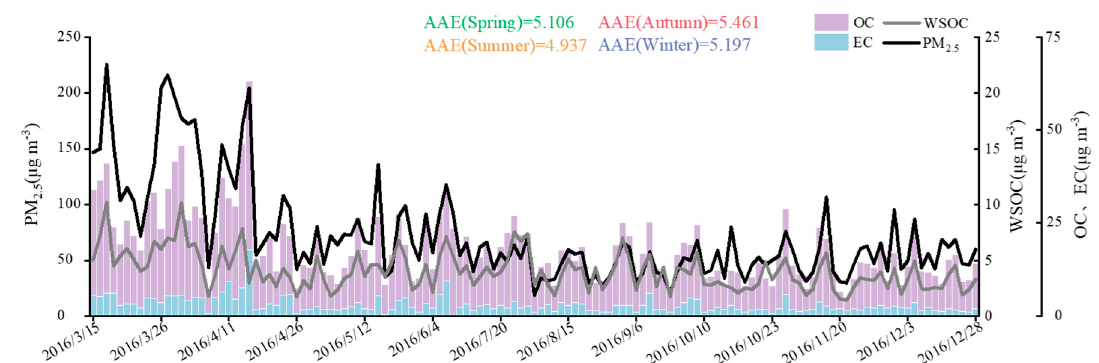
Figure 1. The concentrations of organic carbon (OC), elemental carbon (EC), water soluble organic carbon (WSOC) and ambient fine particle matter (PM 2.5 ) in Nanjing from March to December 2016.